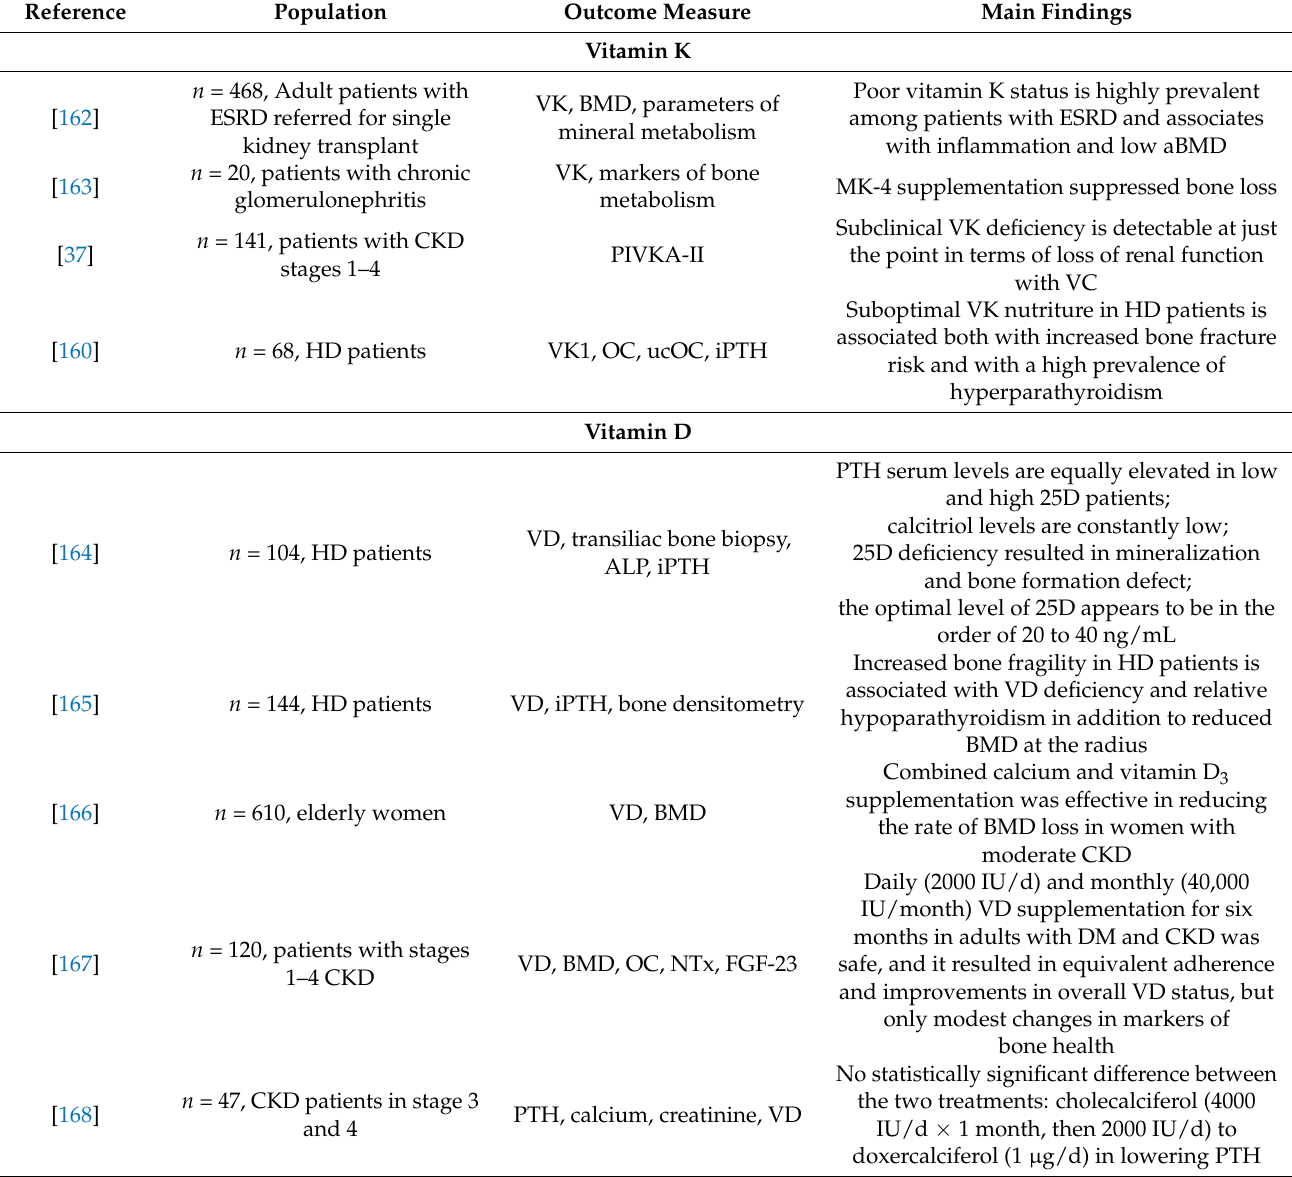
Table 3. Vitamin K, vitamin D, and bone health in patients with CKD—clinical